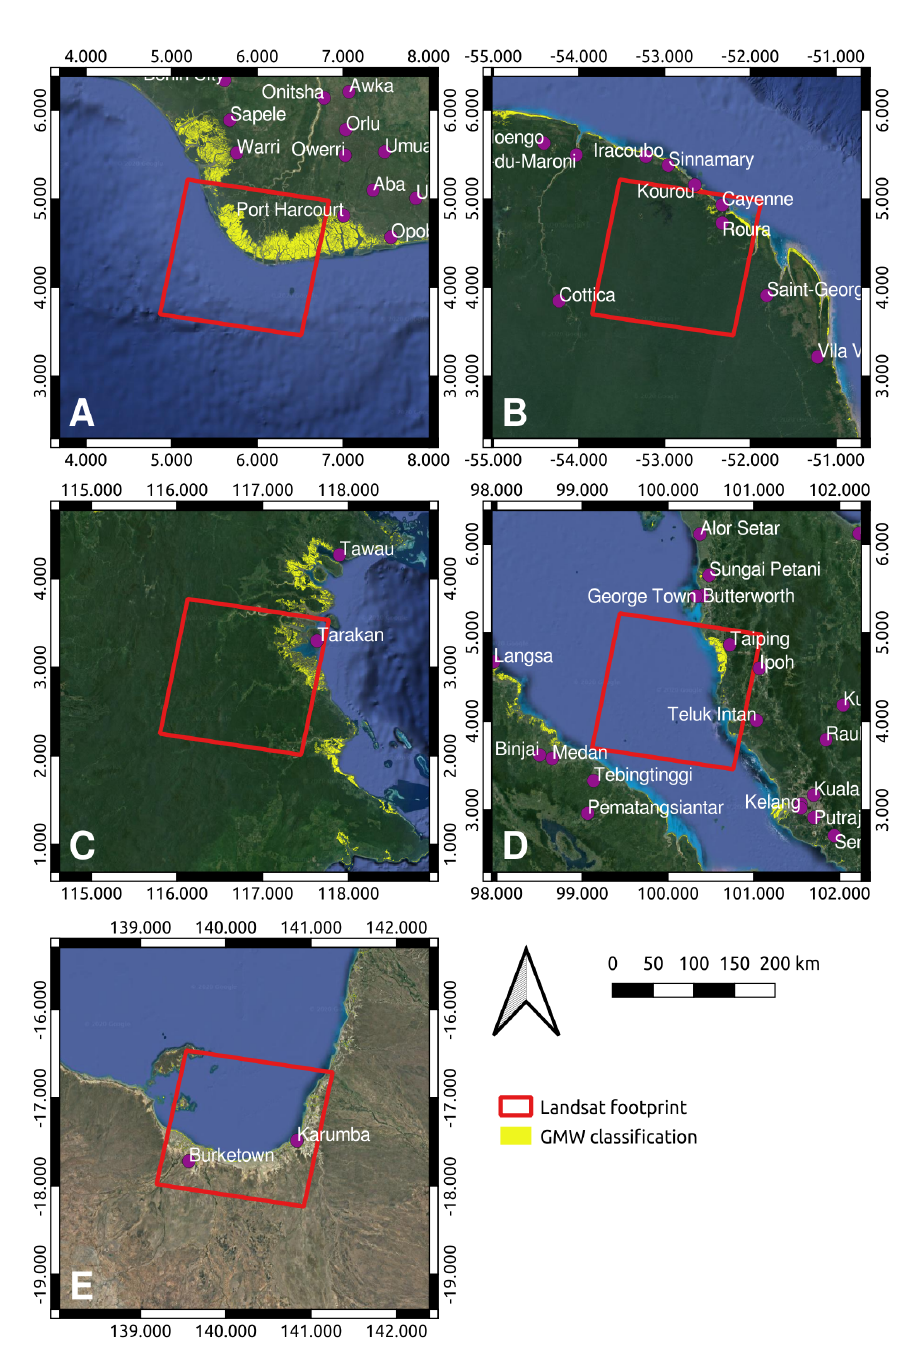
Figure 2. Overview of each of the five study sites. ( A ) Niger Delta, Nigeria ( B ) French Guiana ( C ) North Kalimantan, Borneo island ( D ) Matang Forest Reserve, Malaysia ( E ) Gulf of Carpentaria, north Australia. GMW = Global Mangrove